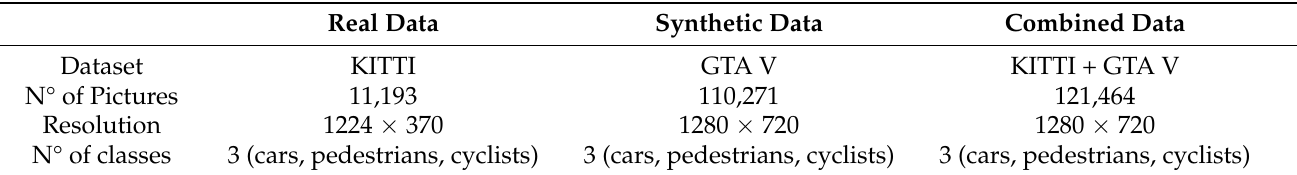
Table 3. Data distribution between KITTI and our GTA